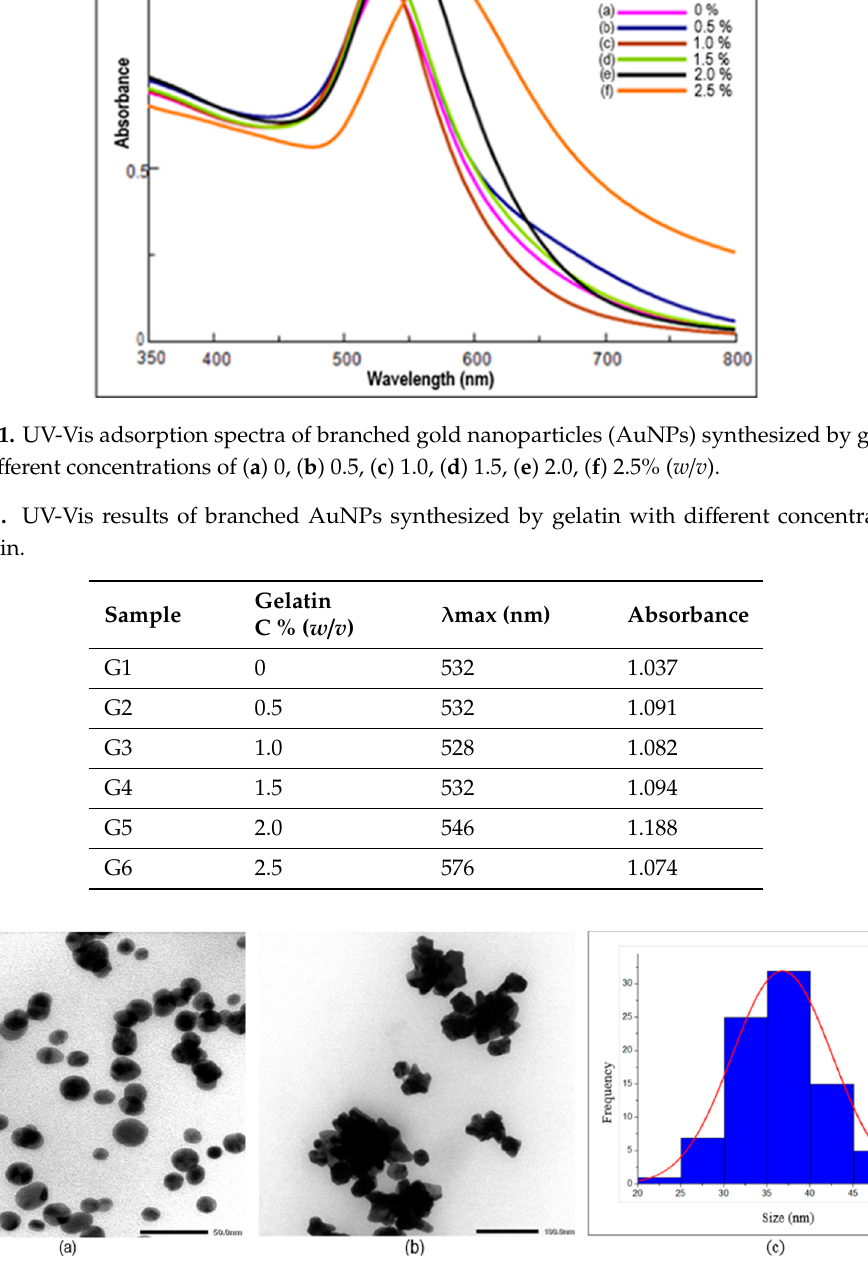
Figure 2. Representative TEM images of synthesized AuNPs with ( a ) low gelatin concentration (1.0% w/v) (scale 50 nm), ( b ) high gelatin concentration (2.5% w/v) (scale 100 nm) and ( c ) histogram of particle size distribution of synthesized AuNPs with low gelatin concentration (1.0% w/v).